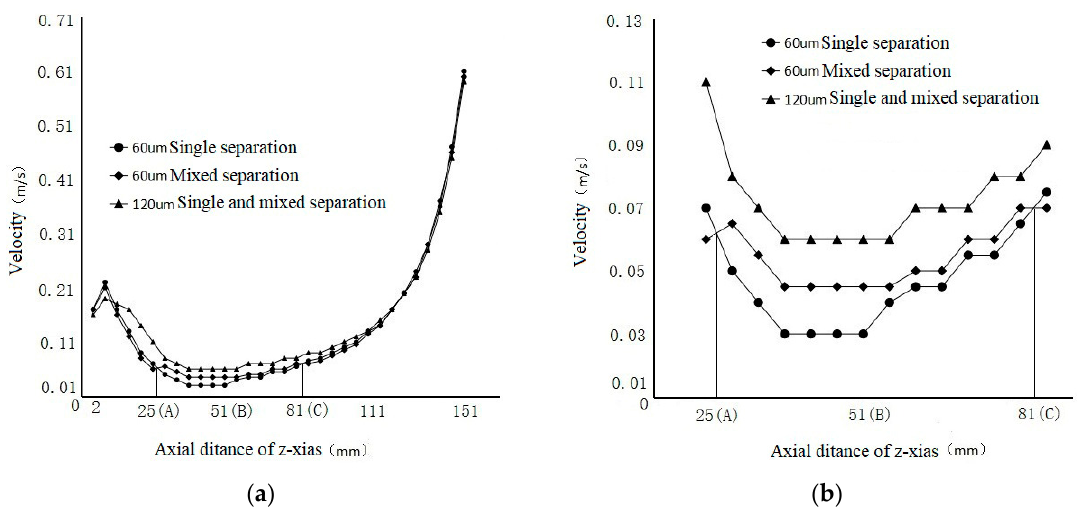
Figure 6. Average velocity distribution in a positive direction of Z axis: ( a ) radial velocity of 60 and 120 µm particles; ( b ) partially enlarged image of ( a ).